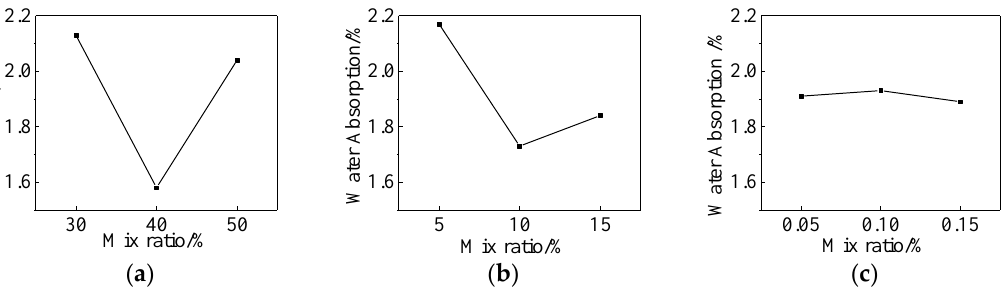
Figure 2. Impact of each factor on 48-h water absorption, ( a ) Lithium silicate; ( b ) Sodium silicate; ( c ) Surfactant.